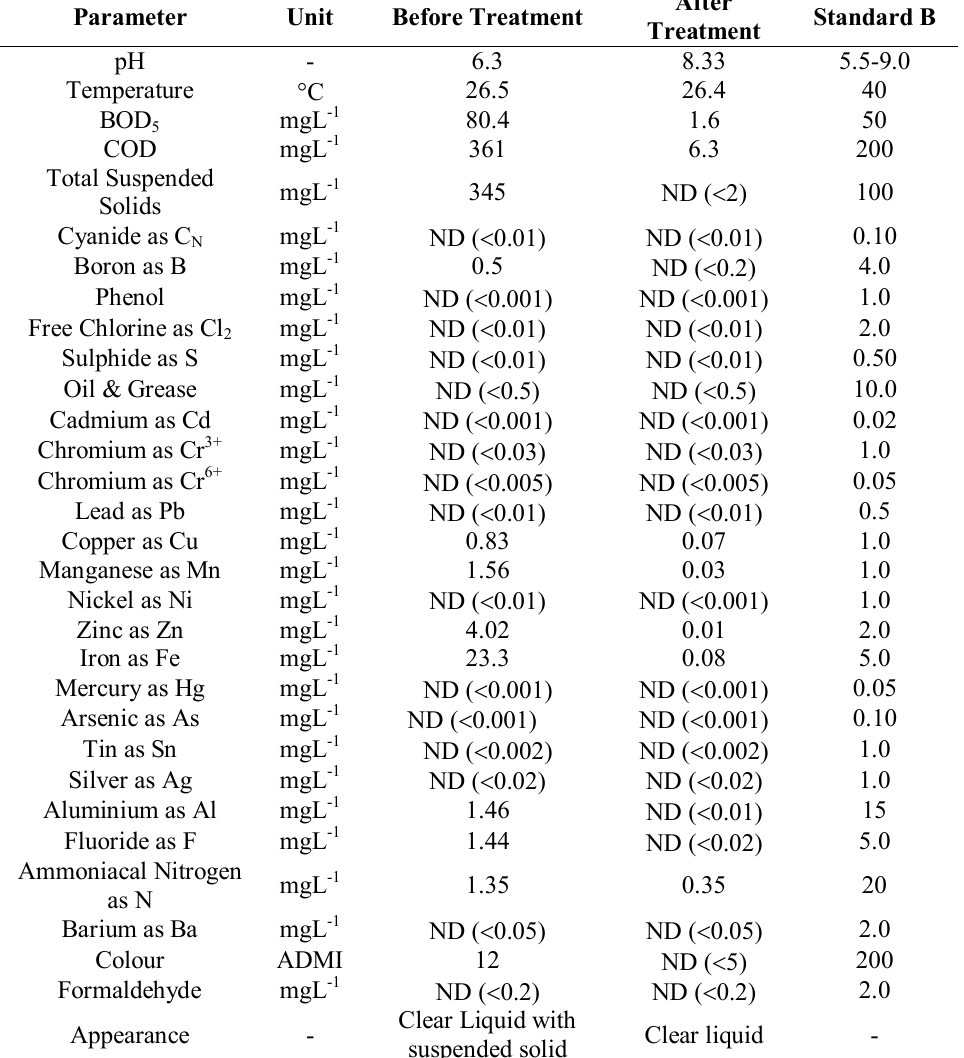
Table 2. Characteristic of Influent and Effluent of still making